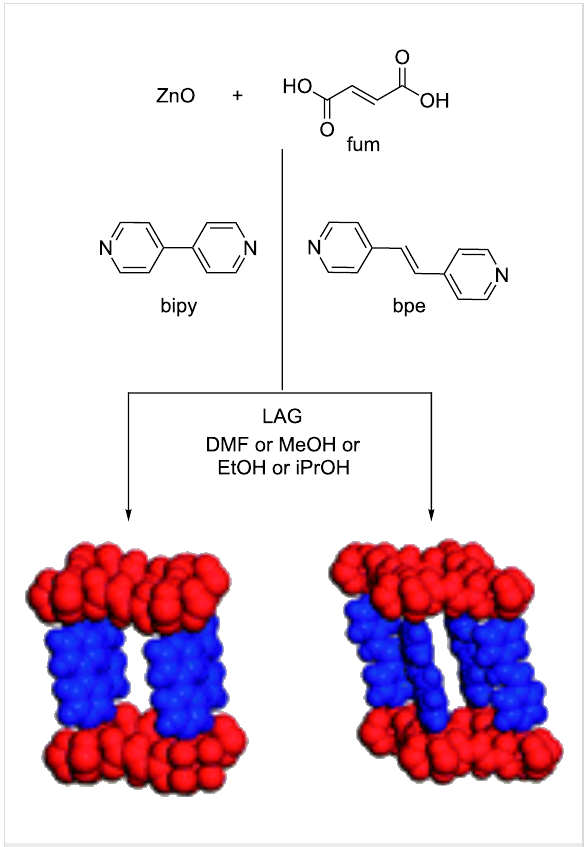
Figure 5: Mechanochemical synthesis of pillared MOFs from ZnO, fumaric acid and two auxiliary ligands (bipy and bpe). Reprinted with permission from [136], copyright 2009 the Royal Society of Chemistry.